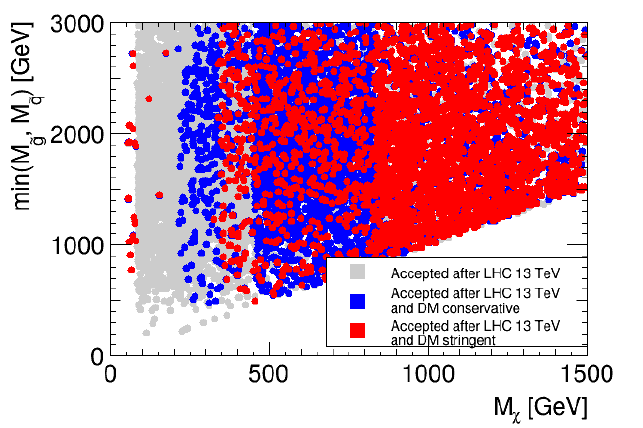
Figure 19 . pMSSM points in the ( M (cid:31) ; M ~ g; ~ q ) parameter plane. M ~ g; ~ q is the lightest mass among the gluino and (cid:12)rst and second generation squark masses. The accepted parameter points which are in agreement with the LHC 8 and 13 TeV data from Higgs and direct searches are shown in gray. The points which in addition agree with dark matter constraints with conservative astrophysical hypotheses are in blue, and with stringent hypotheses in red.